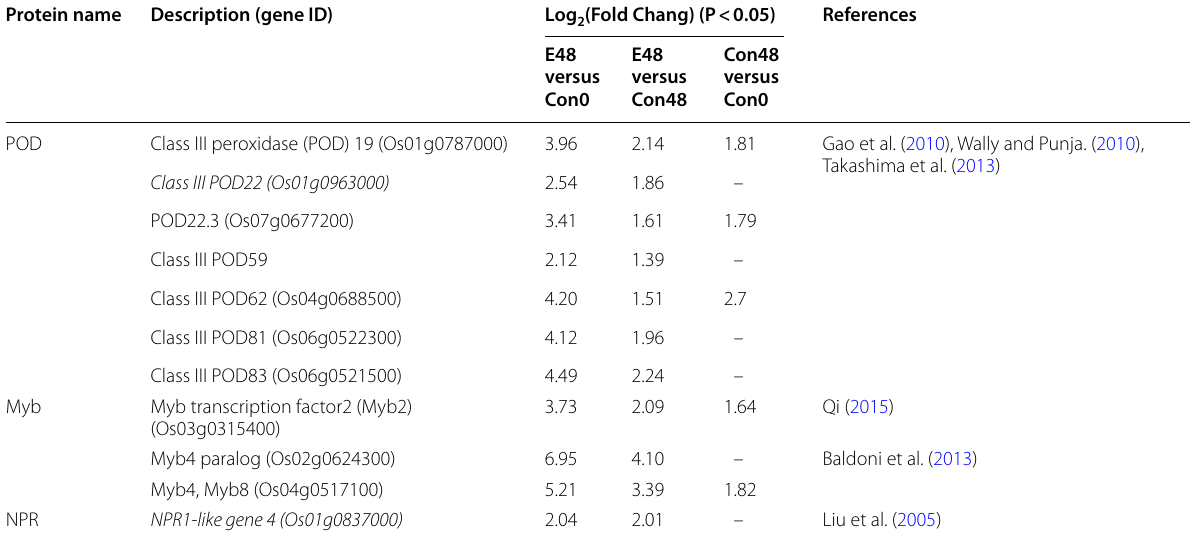
The italic font represents the genes used in qPCR validation in Fig. 8. “